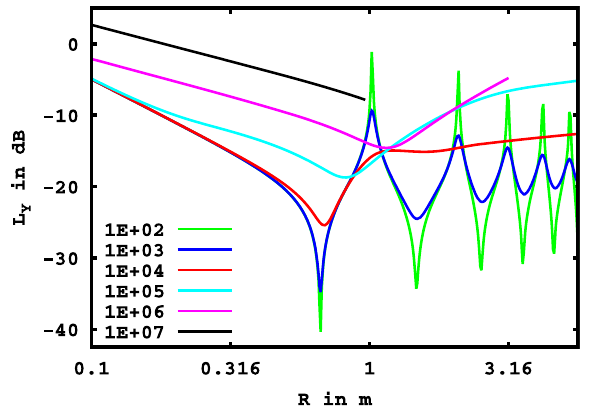
Figure 23. Level of admittance L Y according to (56); at frequency f = f 2 ; r according to legend (unit: Pa s/m 2 ).